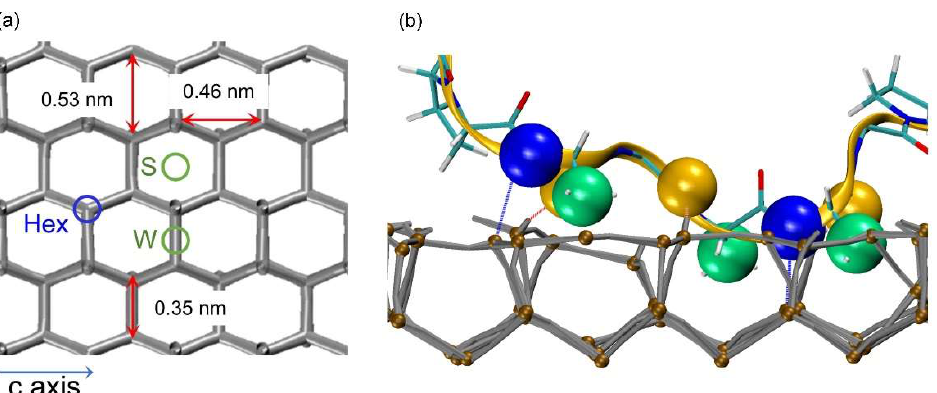
Figure 7. Amide groups and methyl groups cooperatively promote the binding of AFGP8 to ice. ( a ) The lattice parameters of ice Ih prism surface (red double arrow line) and the binding sites of AFGP8 on ice prism surface. S and W (green circles) are the binding sites of methyl groups. Hex (blue circles) are the binding sites of amide groups (including hydroxy groups), representing the top of O or H atoms at the vertex of the ice hexagon. ( b ) Co-adsorption of methyl groups and amide groups on ice prism surfaces. The color coding: methyl groups (green balls), O (orange balls) and N (blue balls) of amide groups; the backbone of AFGP8 (orange ribbon and colorful sticks); hydrogen bonds (red or blue dashed lines).